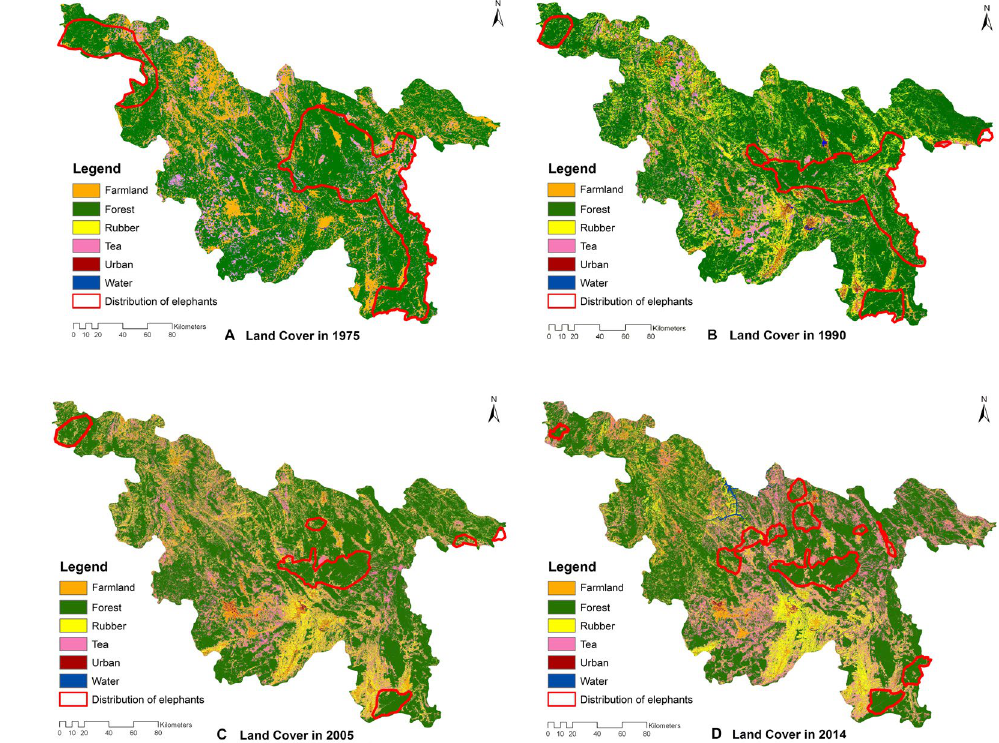
Figure 2. Land cover classification maps with related elephant distributions in 1975, 1990, 2005 and 2014. Software: ArcGIS 10 . 2 ( ESRI Ltd ., CA , USA . www.esri.com).